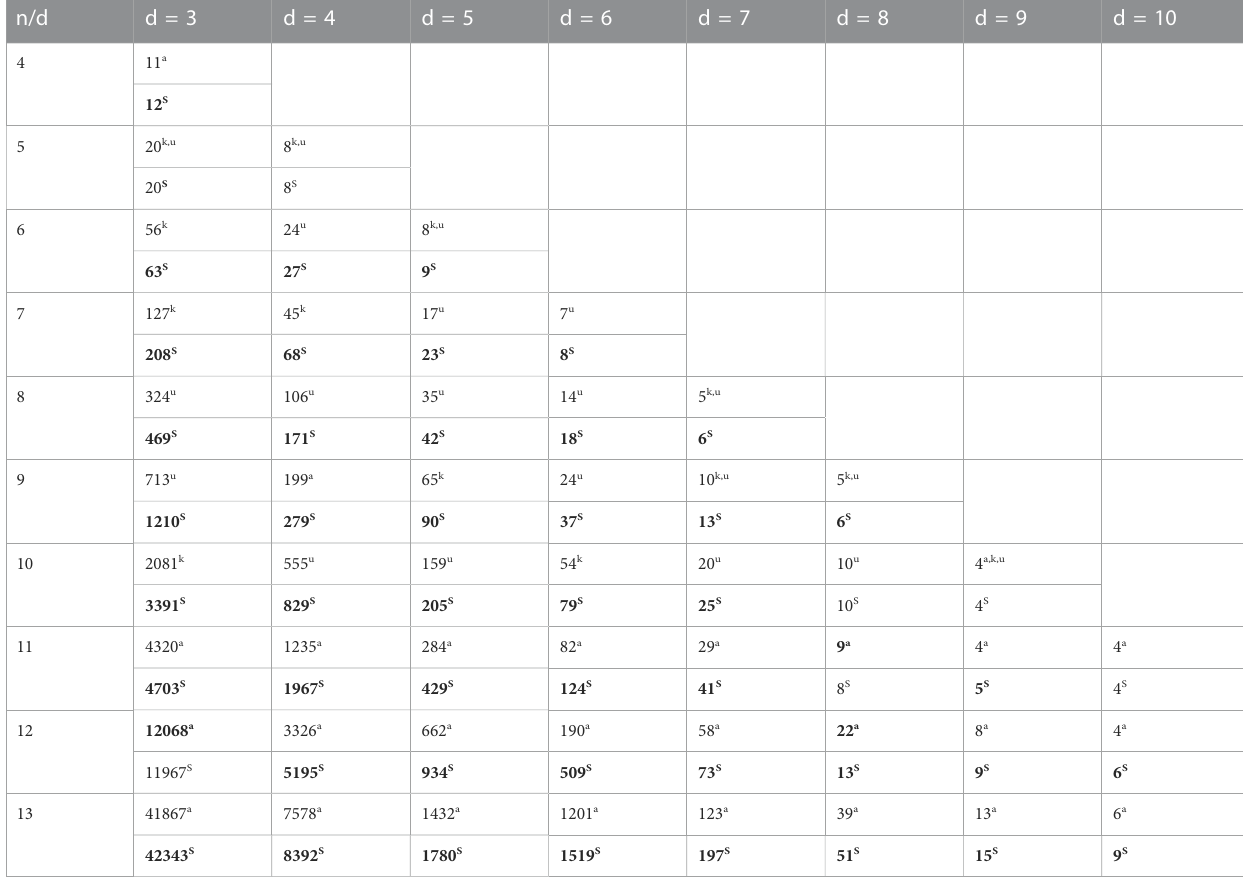
TABLE 3 Lower bounds ’ comparison of the MFOS algorithm with KMVO (Cao et al., 2020a), DMVO (Cao et al., 2020b), and Altruistic algorithm (Limbachiya et al., 2018) for C GC,NL ( n,W,d ) . n/d d = 3